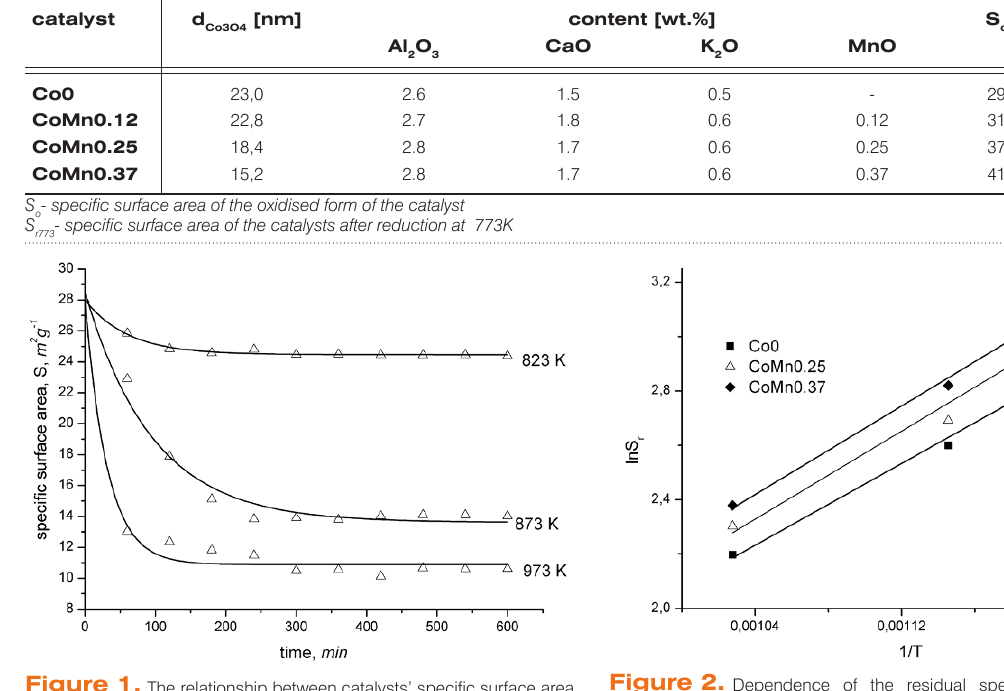
Figure 1. The relationship between catalysts’ specific surface area (CoMn0.25) and the temperature and time of sintering in a reductive atmosphere.